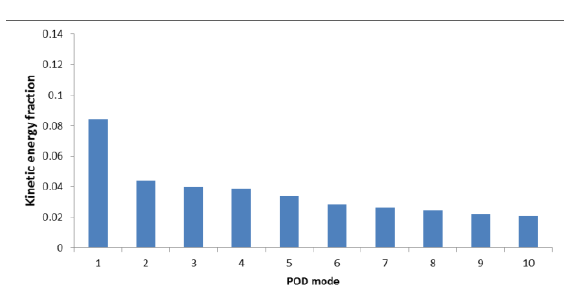
Fig. 8. Relative kinetic energy content of first ten POD modes, the wake region